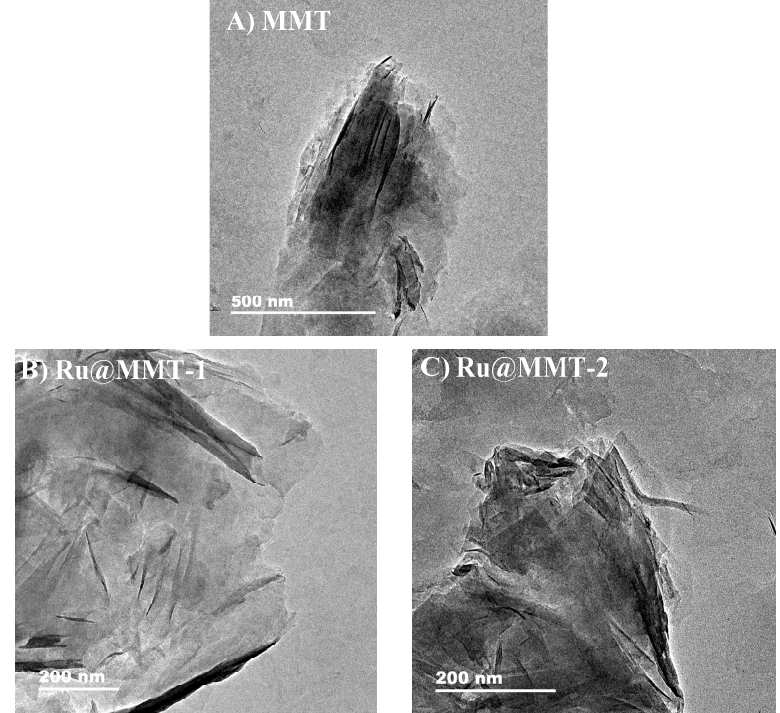
Figure 5. The Transmission electron microscope (TEM) of Na-MMT ( A ), Ru@MMT-1 ( B ) and Ru@MMT-2 ( C ) clarified their layered structures existence.